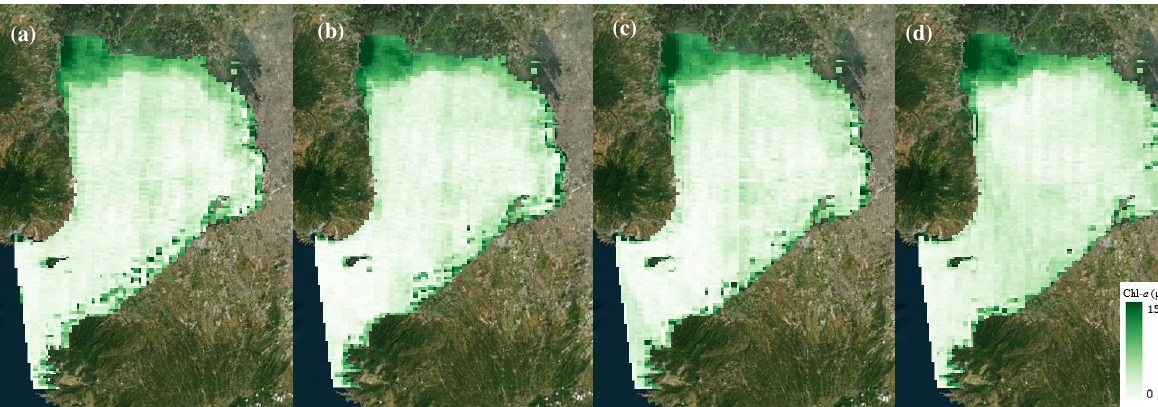
Figure 6. Chl- a maps for April 2, 2019 using the Yearly model: (a) 9:10, (b) 9:30, (c) 9:50, and (d) 10:10 AM.